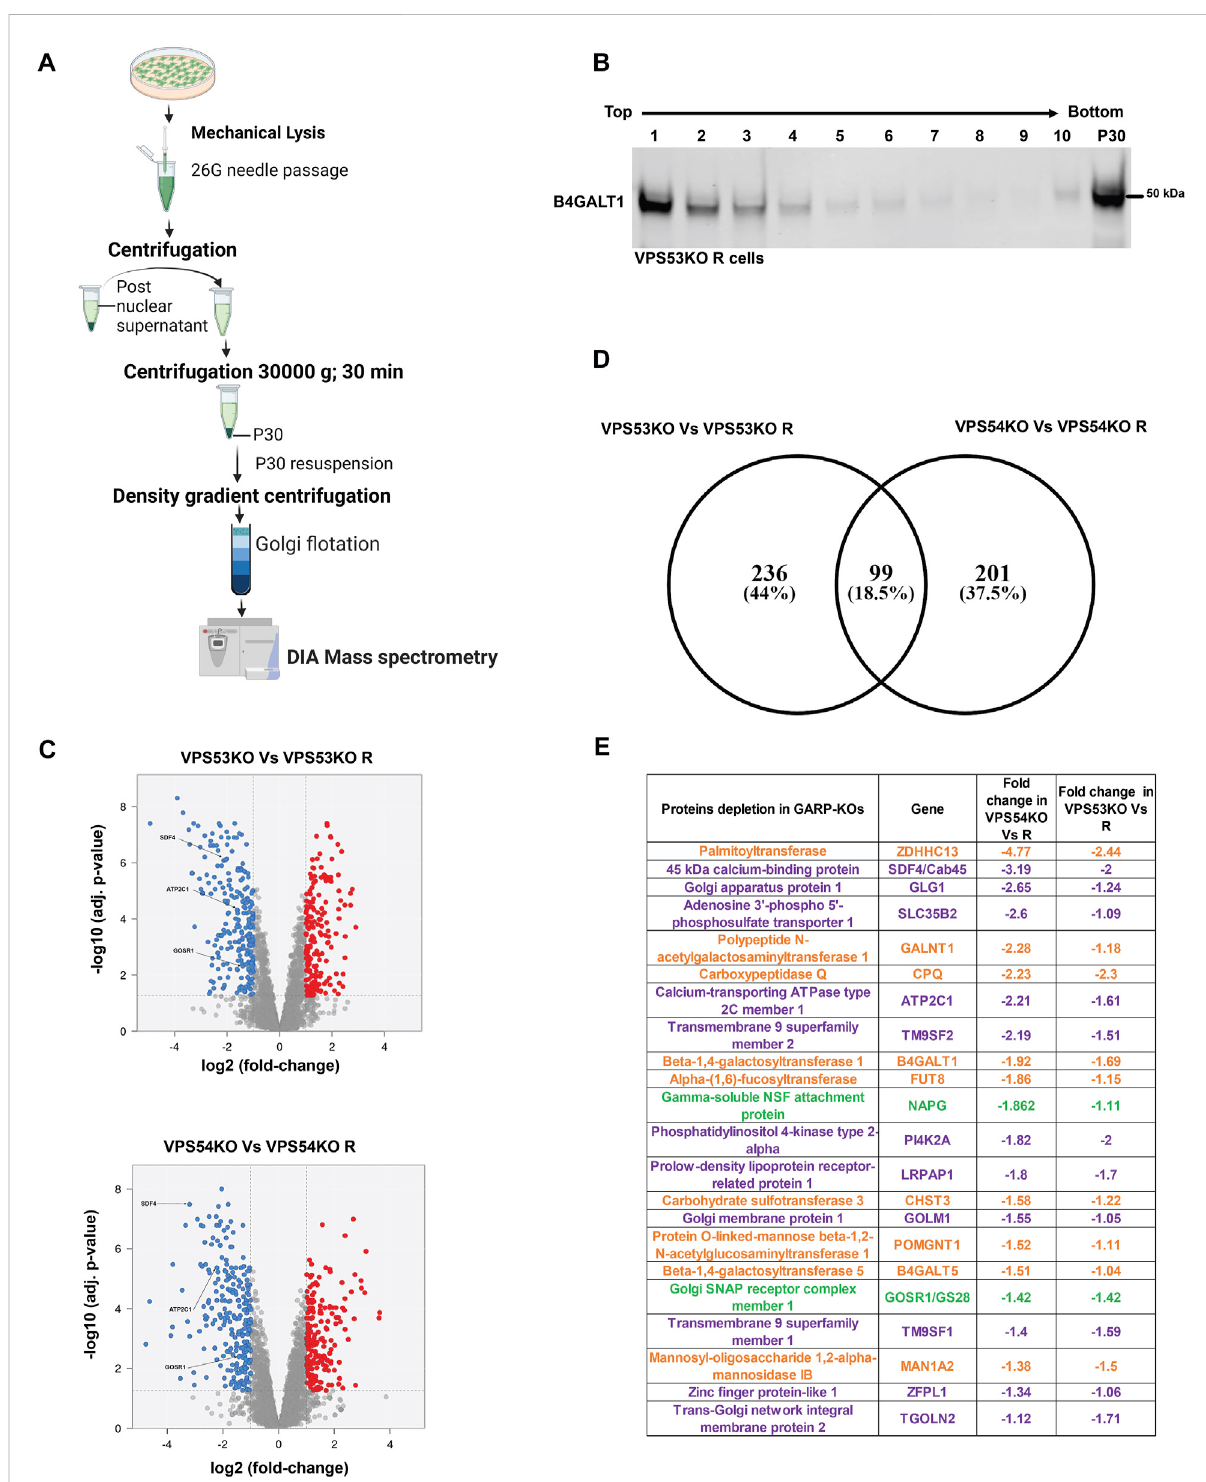
FIGURE 2 QuantitativeMassspectrometry(MS)analysisofGolgi-enrichedmembranesisolatedfromGARP-KOsrevealeddepletionofmultipleGolgiproteins. (A) Schematic of the major steps during preparation of Golgi samples for MS analysis. Schematic was made in BioRender. (B) WB for Golgi marker B4GALT1 in membranes isolated from VPS53KO R cells and separated by the Nycodenz fl otation gradient. (C) Volcano plot analysis of relative protein abundance in VPS53KOandVPS53KOR(Top)andVPS54KOanditsVPS54KORcells(Bottom).Bluecirclesrepresenttheproteinssigni fi cantlydepletedinGARP-KO cells. Red circles represent proteins signi fi cantly increased in GARP-KO cells. Gray circles are proteins with no signi fi cant differences. (D) Venn diagram demonstrating common proteins depleted in both VPS53KO and VPS54KO cells. (E) List of Golgi proteins signi fi cantly depleted in both VPS53KO and VPS54KO cells. Proteins with color orange are Golgi enzymes, purple are Golgi resident proteins, and Green are Golgi